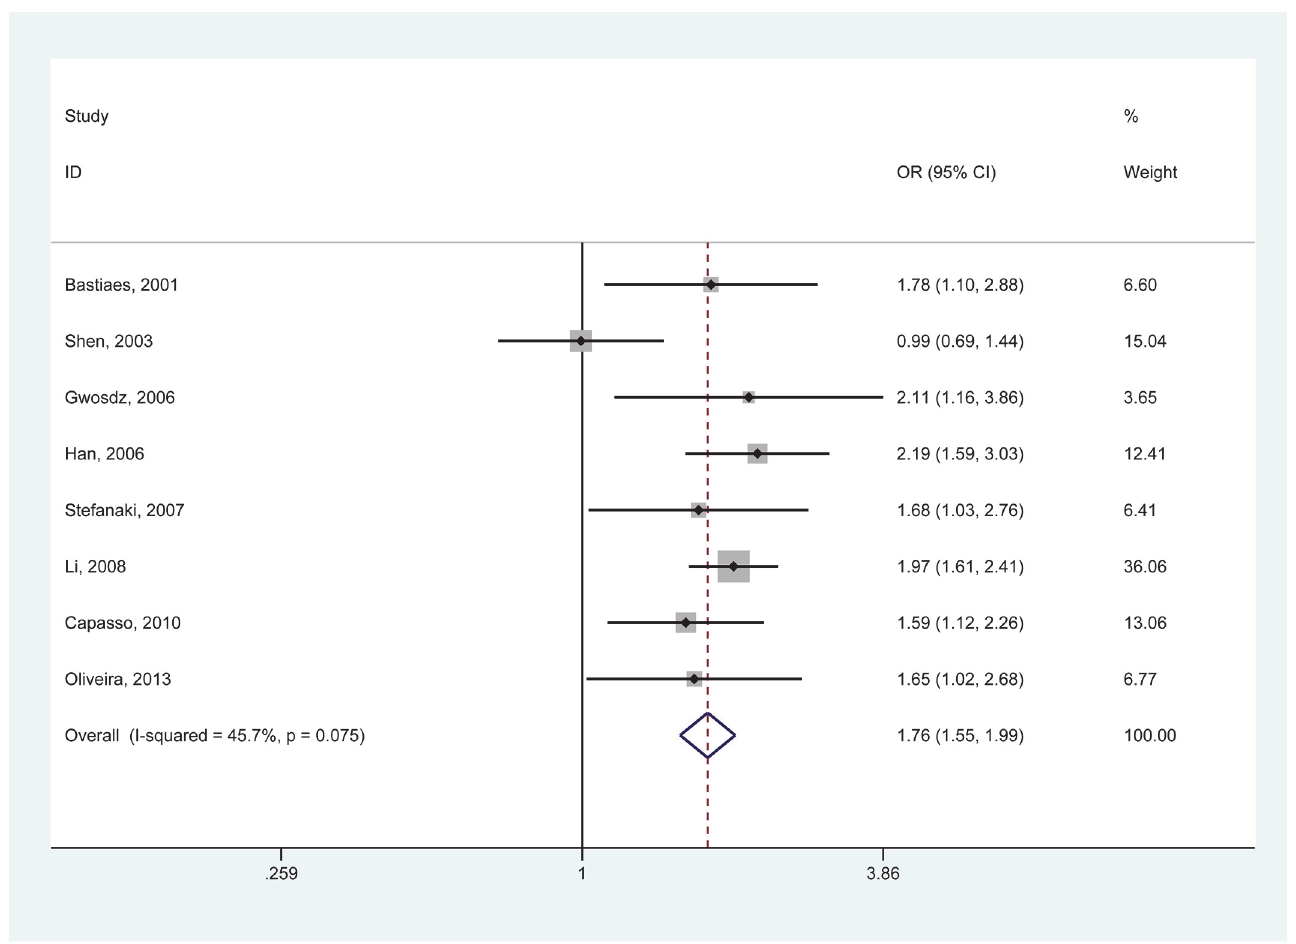
Fig 2. Forest plot (Fixed effects model) describing the association of the p53 Arg72Pro polymorphism with cutaneous melanoma (CM). The p53 Arg72Pro polymorphism shows a signficant association with risk of CM (Arg/Pro vs. Pro/Pro).